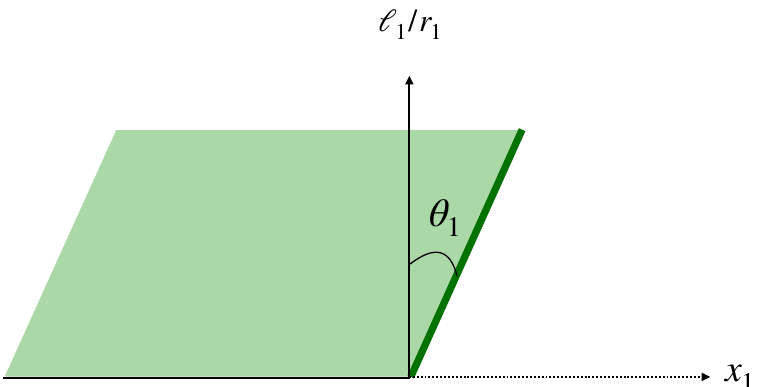
Figure 4 . Near the AdS boundary in the ( x j , ‘ j /r j ) plane the string is a straight line subtending an angle θ with the j